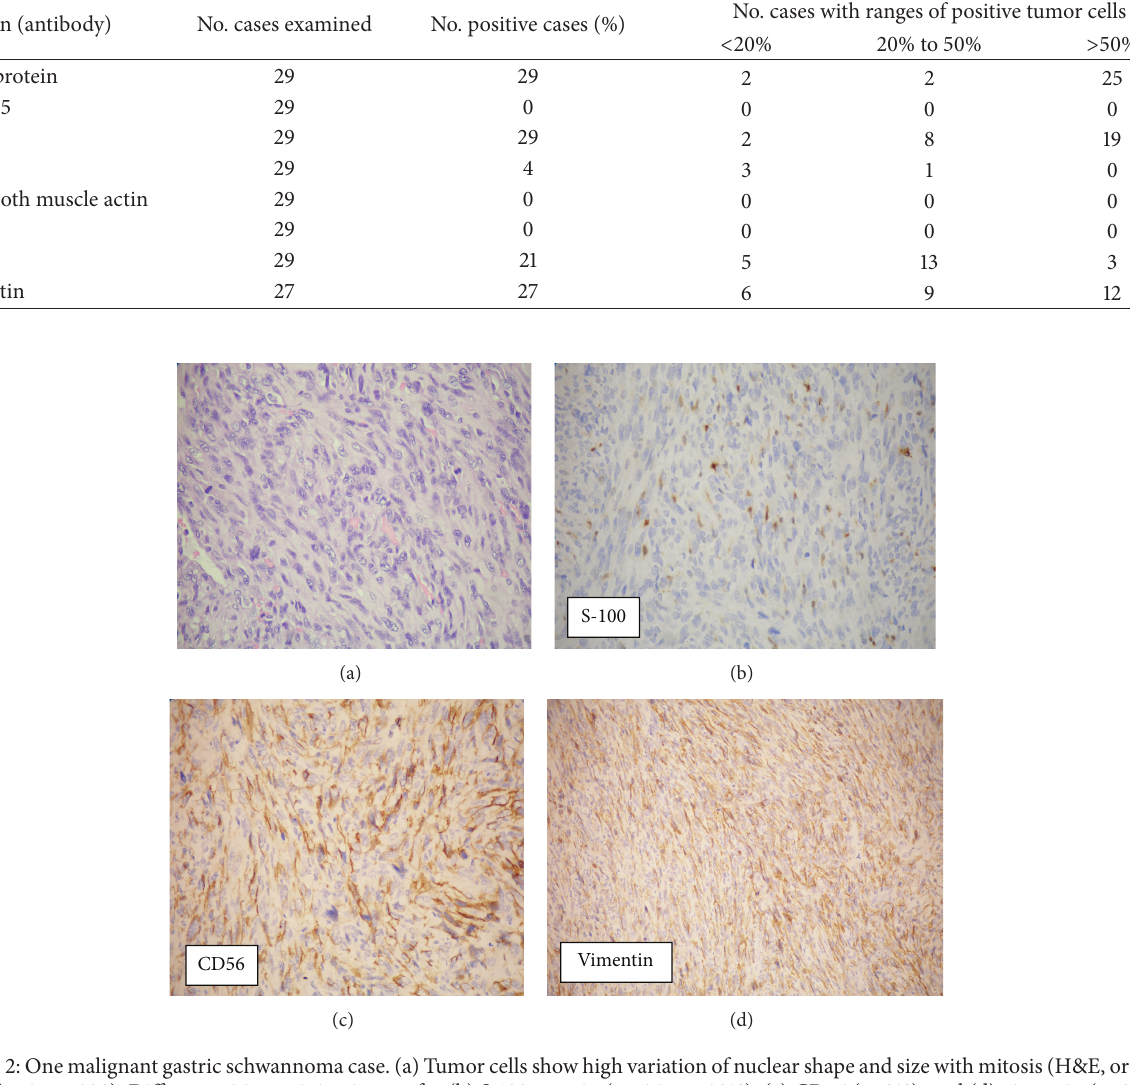
Figure 2: One malignant gastric schwannoma case. (a) Tumor cells show high variation of nuclear shape and size with mitosis (H&E, original magnification × 200). Diffuse positive staining is seen for (b) S-100 protein (positive < 20%), (c) CD56 ( > 50%), and (d) vimentin ( > 50%) in tumor